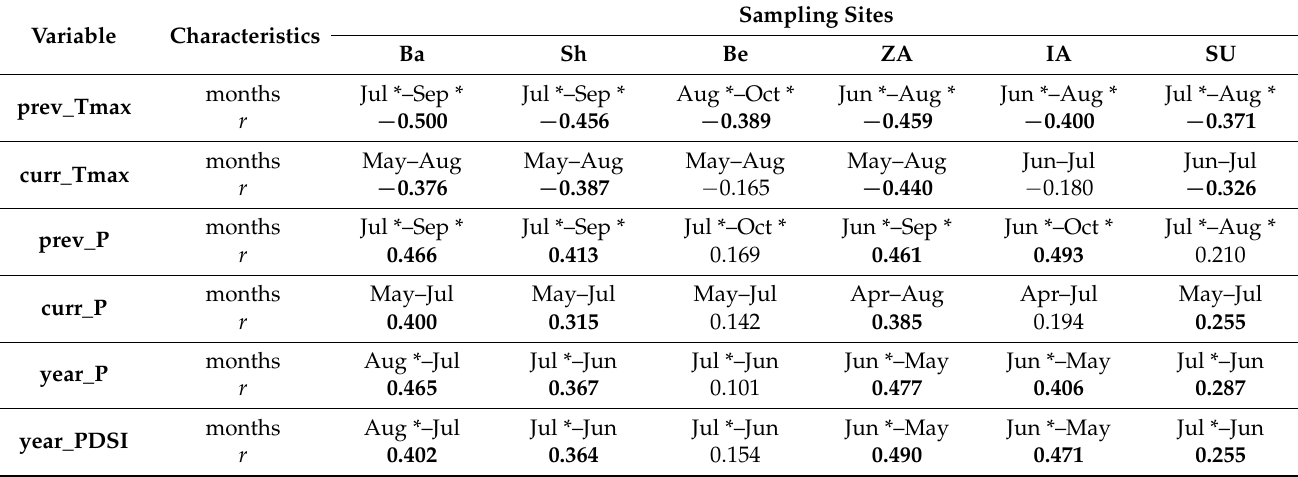
Table 4. Seasonal climatic variables and their deviations for pointer years (years with the highest/lowest tree-ring width indices) at each sampling site (Ba—Bayanaul, Sh—Shalday, Be—Beskaragay, ZA—Zhongar-Alatau, IA—Ile-Alatau, and SU—Sairam-Ugam). Climatic variables are average maximal temperature for previous (prev_Tmax) and current growing season (curr_Tmax), sum of precipitation for previous (prev_P) and current growing season (curr_P), annual sum of precipitation (year_P), and average SPEI